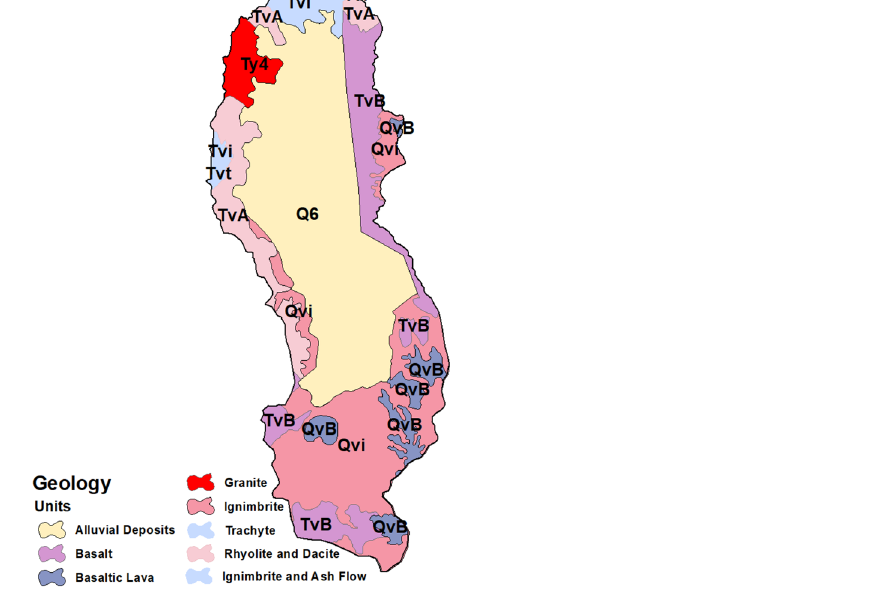
Figure 2. Geological map of the study area (Developed by the first author using ArcGIS (v. 10.3), https:// suppo rt. esri. com, geological map digitized from the Dhamar geological map obtained from the Yemeni Geological Survey, https:// ygsmrb. org. ye/ (free available).